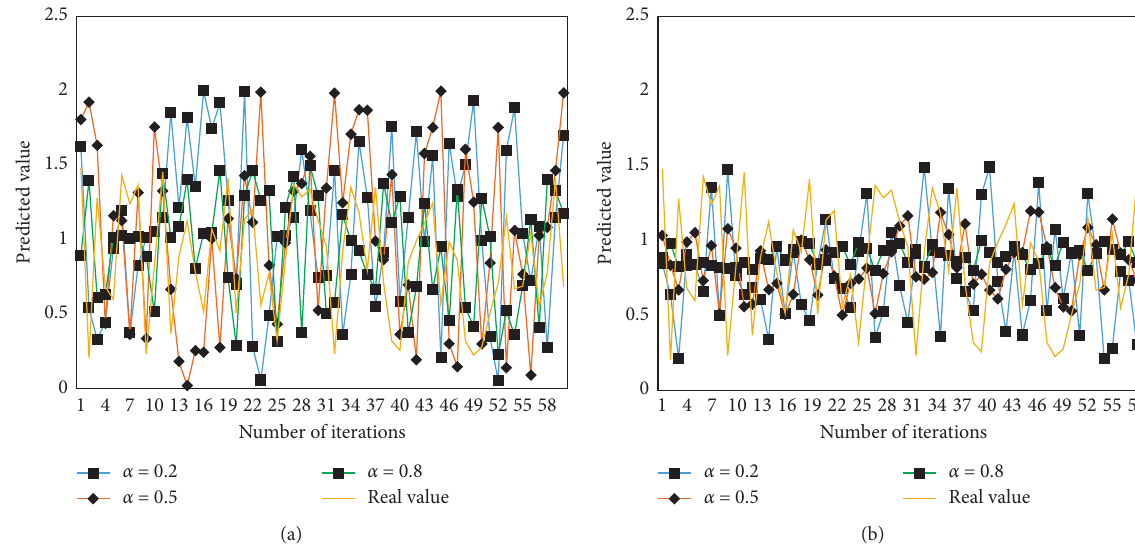
Figure 5: Exponential forecast chart of first smoothing and second smoothing. (a) Smooth once. (b) Smooth second.